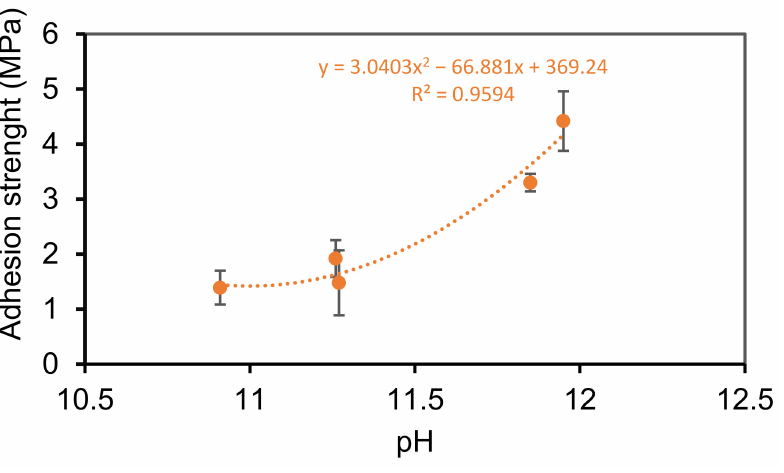
Figure 3. Correlation between pH and adhesion